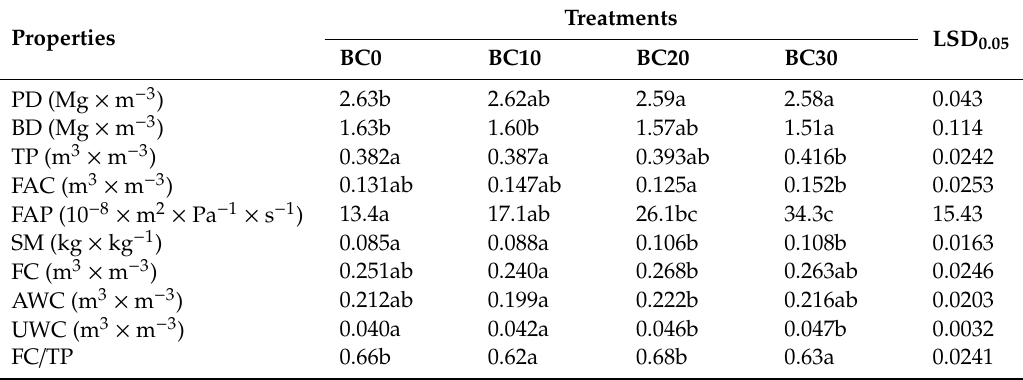
Table 3. Mean values of soil physical properties for treatments in the 2010–2019